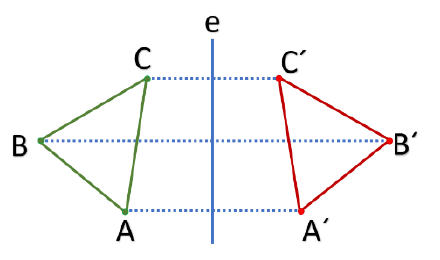
Figure 1. Example of geometric axial symmetry.